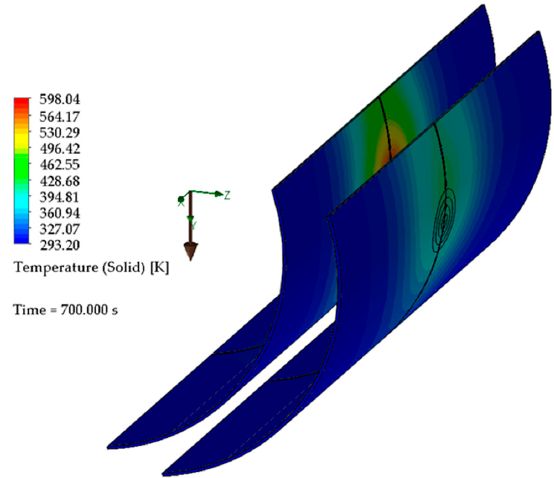
Figure 20. Temperature at 700 s.